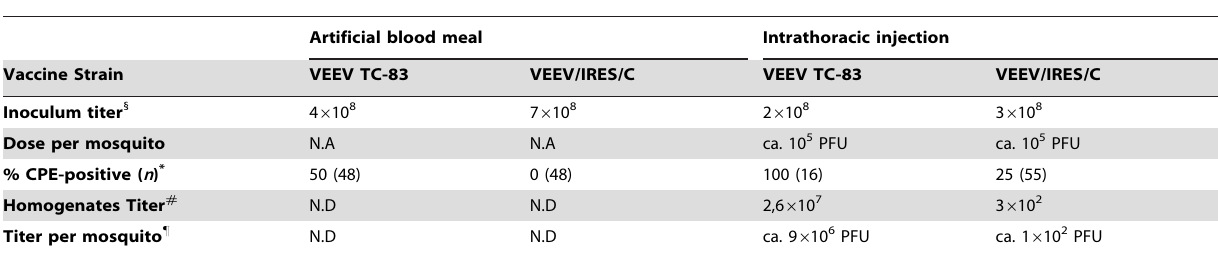
Table 1. Virus replication in Ae. aegypti